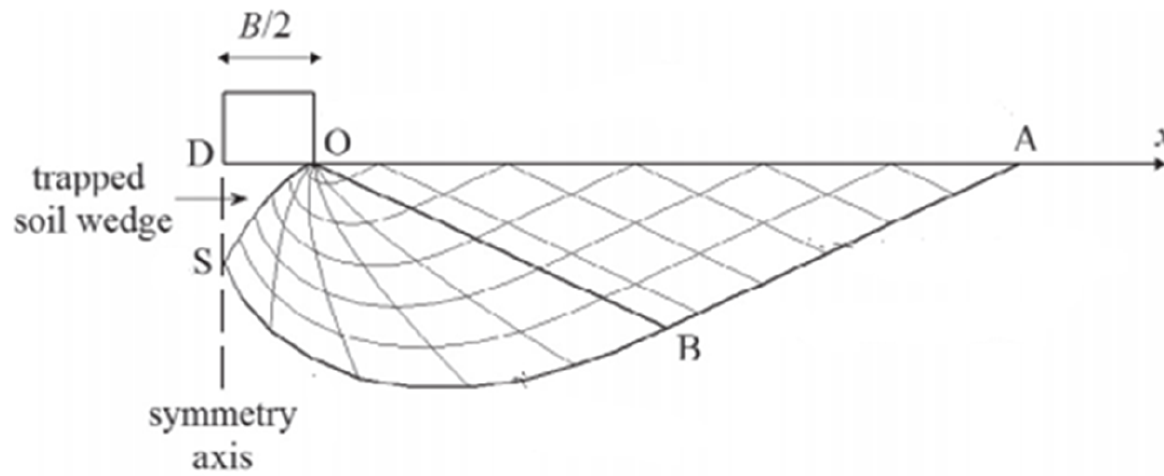
Figure 6. Slip-line field of strip footing.